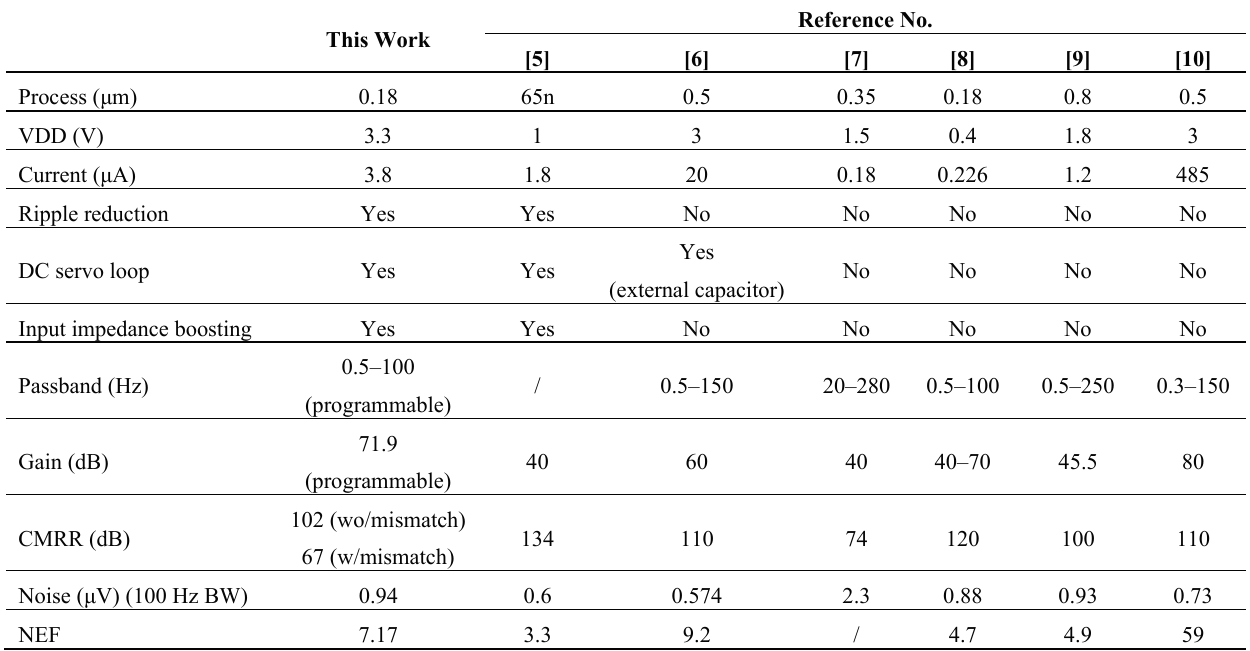
Table 1. Performance